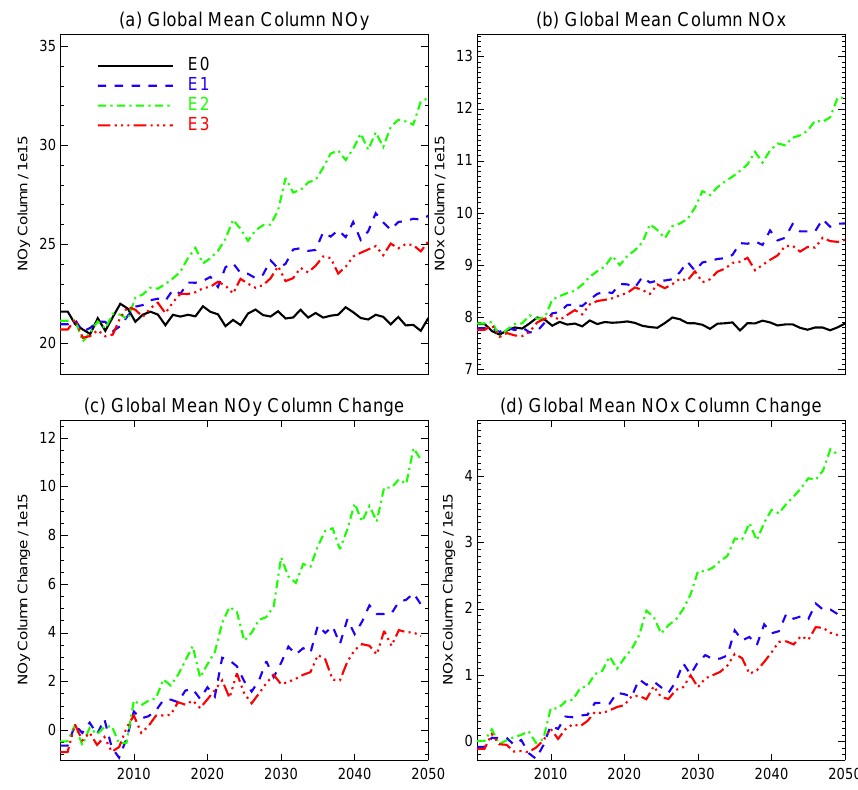
Figure 1. Time series of global mean (a) column NO y (moleculescm − 2 ) and (b) column NO x (moleculescm − 2 ) in E0 (black line), E1 (blue line), E2 (green line) and E3 (red line). Difference in (c) column NO y and (d) column NO x between E1 and E0 (blue line), E2 and E0 (green line), E3 and E0 (red